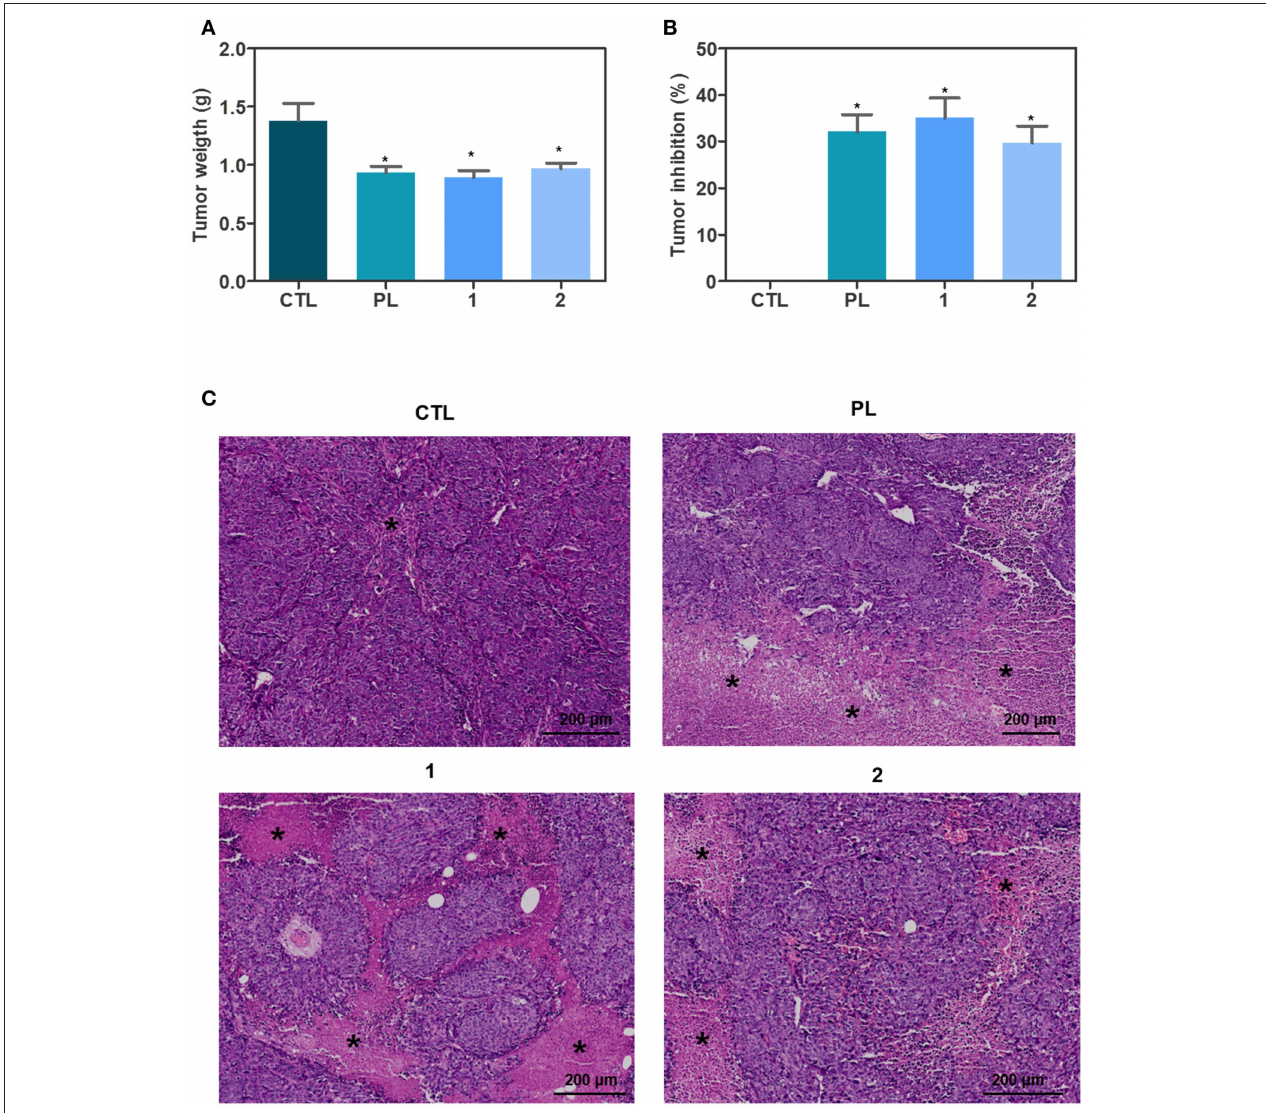
FIGURE 6 | In vivo antitumor activity of ruthenium complexes with piplartine in C.B-17 SCID mice with HCT116 cell xenografts. (A) Quantification of tumor weight (g). (B) Quantification of tumor inhibition (%). Data are presented as mean ± S.E.M. of 10–11 animals. * P < 0.05 compared with negative control by ANOVA, followed by Student-Newman-Keuls test. (C) Representative histological analysis of the tumors stained with hematoxylin and eosin and analyzed by optical microscope. The asterisks represent areas with tumor necrosis. The treatments were initiated 1 day after the cancer cell injection. Animals were treated intraperitoneally once a day for 15 consecutive days. Negative control (CTL) was treated with the vehicle (5% of a solution containing 70% sorbitol, 25% tween 80 and 5% water) used for diluting the complexes. Piplartine (PL, 60 µ mol/kg) was used as positive control.